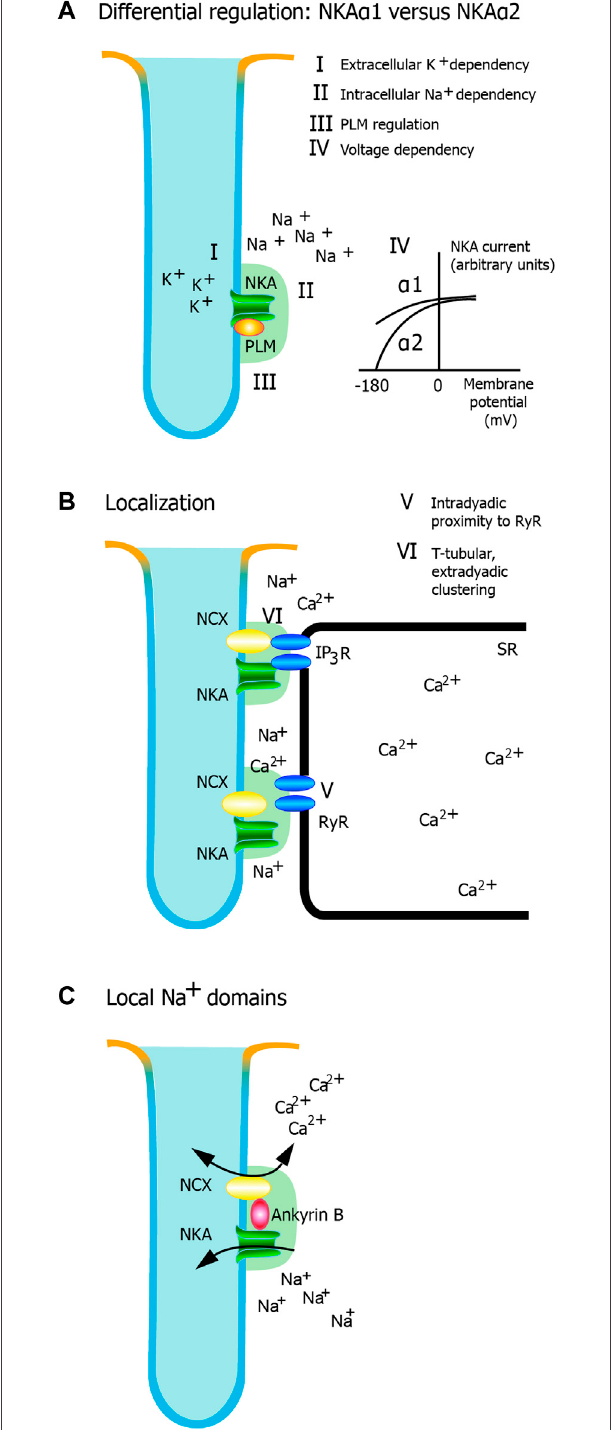
FIGURE 1 | regulation mediated through phospholemman, and iv) voltage dependency. Only the extracellular K + dependency and the voltage dependency are markedly different between NKA α 1 and NKA α 2. (B) Localization. There is a relative clustering of NKA α 2 in the t-tubules. v) Intradyadic proximity to RyR and vi) T-tubular, extradyadic clustering (po-